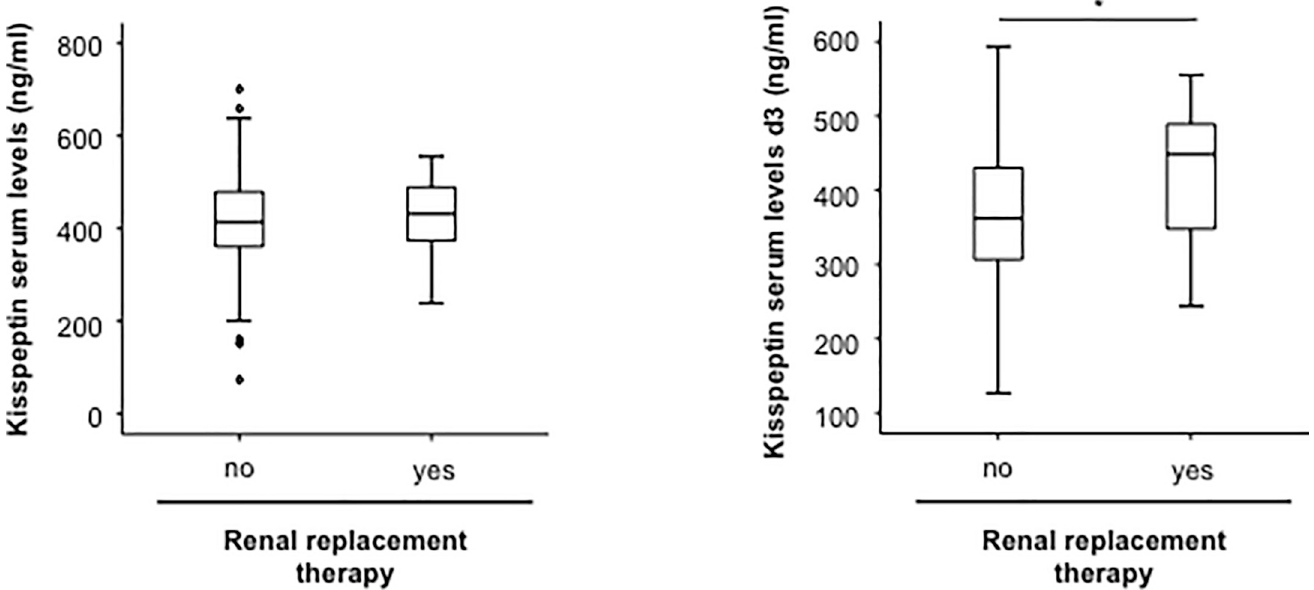
Fig 6. Alterations in kisspeptin serum levels in patients with renal replacement therapy. (a) Serum concentrations of kisspeptin measured at the time-point of admission to the ICU in patients with or without need for renal replacement therapy. (b) Serum concentrations of kisspeptin measured at d3 in patients with or without need for renal replacement